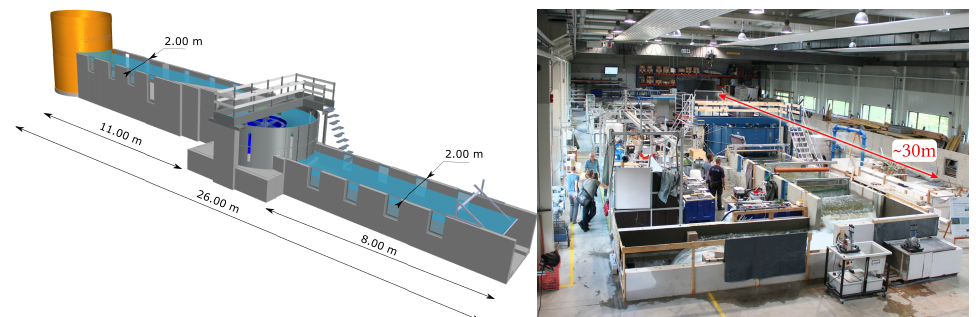
Figure 1. ( Left ): computer drawing of the device with its main dimensions. In both images, the flow is from top left to bottom right, with the turbine basin in the center. ( Right ): photograph of the WVPP installation in the laboratory of the Technische Universität Dresden. (drawing reproduced from Powalla et al. 2021 [24], with geometry provided by Ecoligent